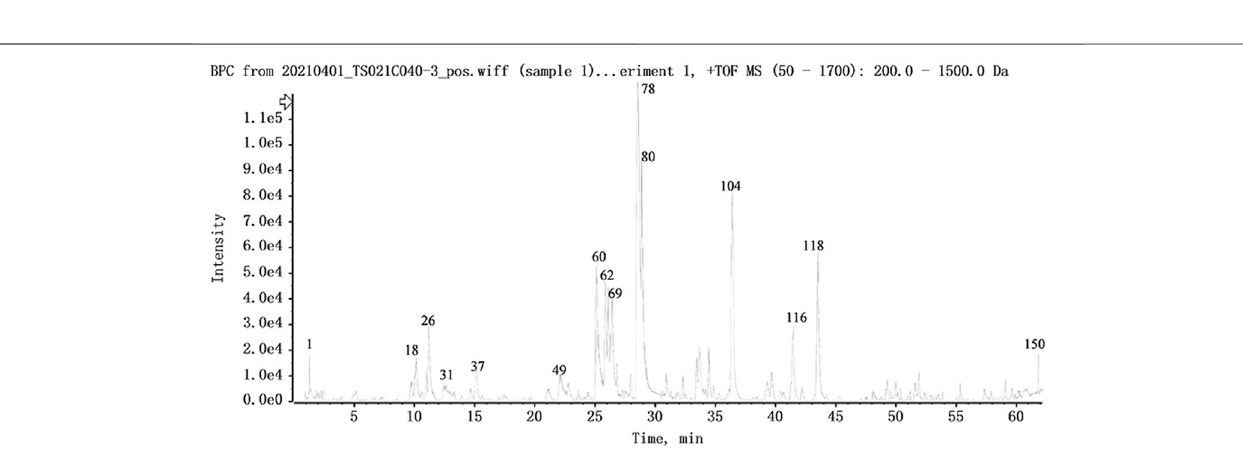
FIGURE 4 | The base peak intensity chromatogram of NFPX by UPLC-HRMS in negative ion mode.